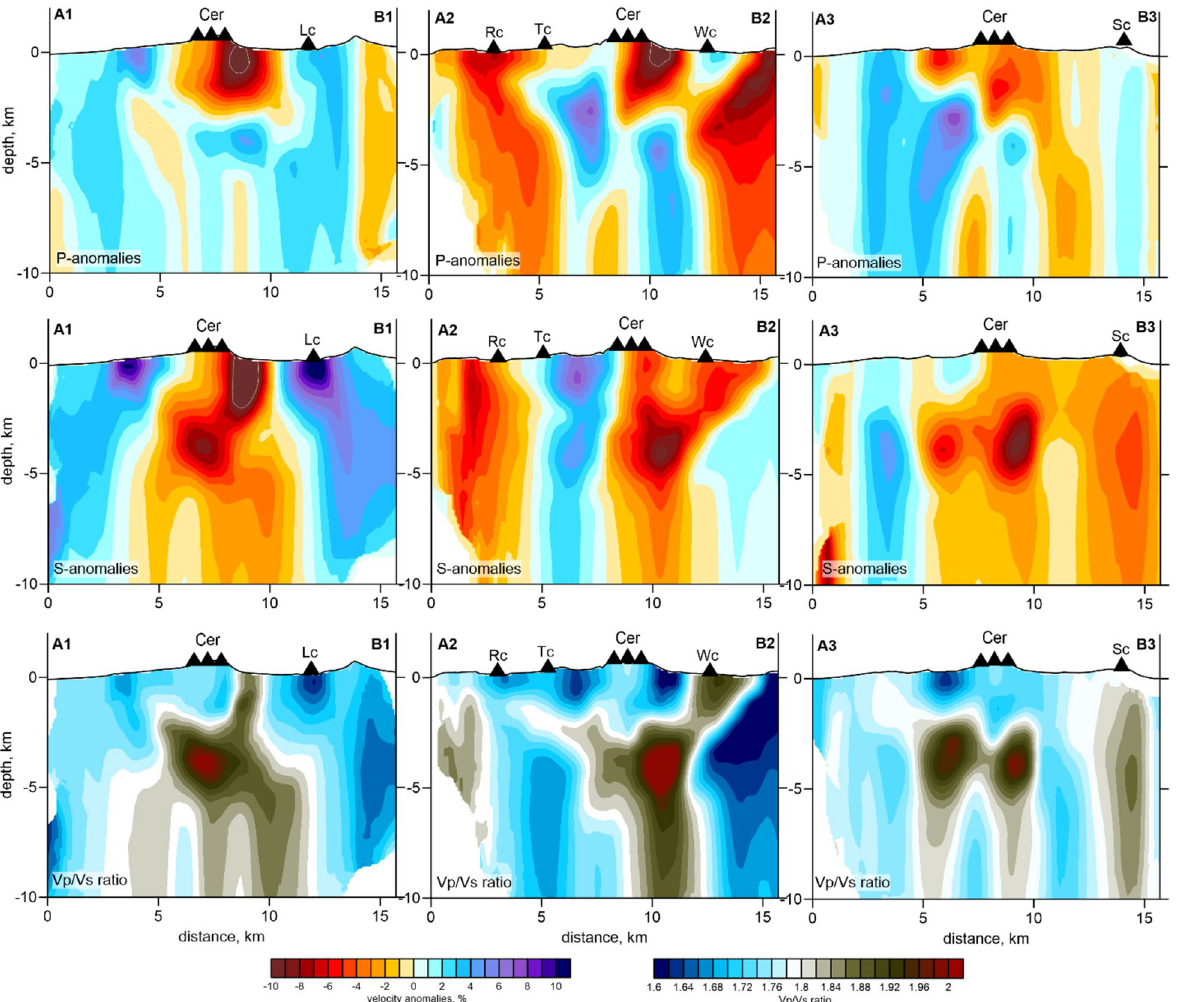
Figure 7. Distribution of the Vp and Vs anomalies and the Vp / Vs ratios obtained from the inversion of the experimental data in three vertical sections, as indicated in Fig. 6. The projections of the main volcanic vents are shown as black triangles. Cer cerberus stratovolcano, RC ringworm cone, Tc threequarter cone, Wc windy cone, Lc lakeshore cone, Sc sugarloaf cone. The figure was generated using the software Surfer (version 13, http:// www. golde nsofw are. com/ produ cts/